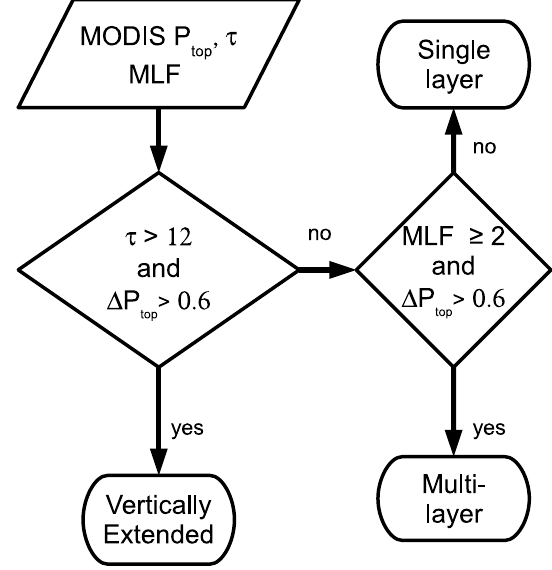
Fig. 4. Flow chart describing MODIS multi-layer/extended cloud detection